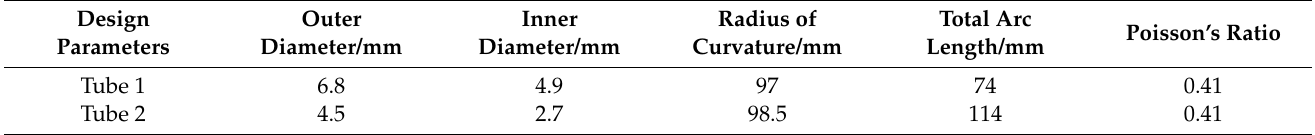
Table 1. Concentric tube basic